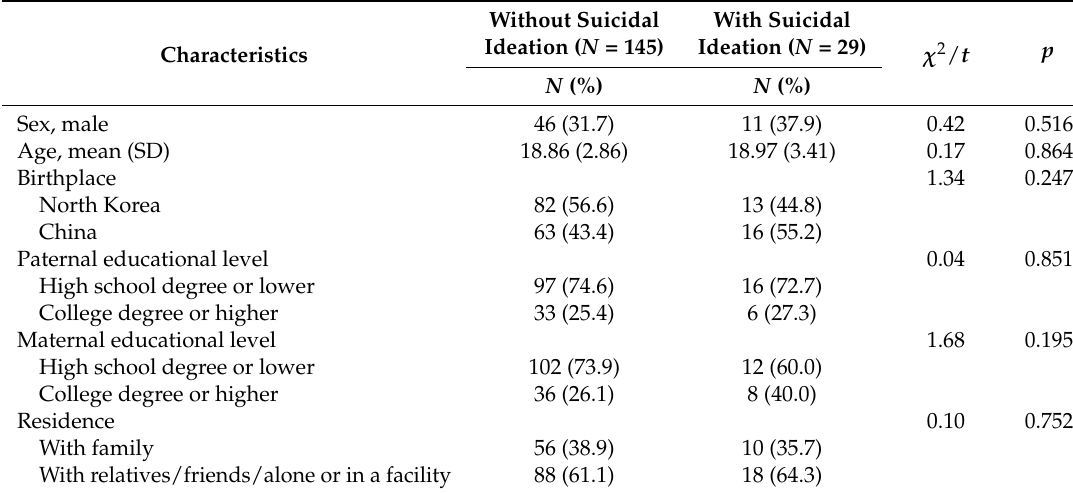
Table 1. Sociodemographic characteristics of North Korean refugee youths with and without suicidal ideation.